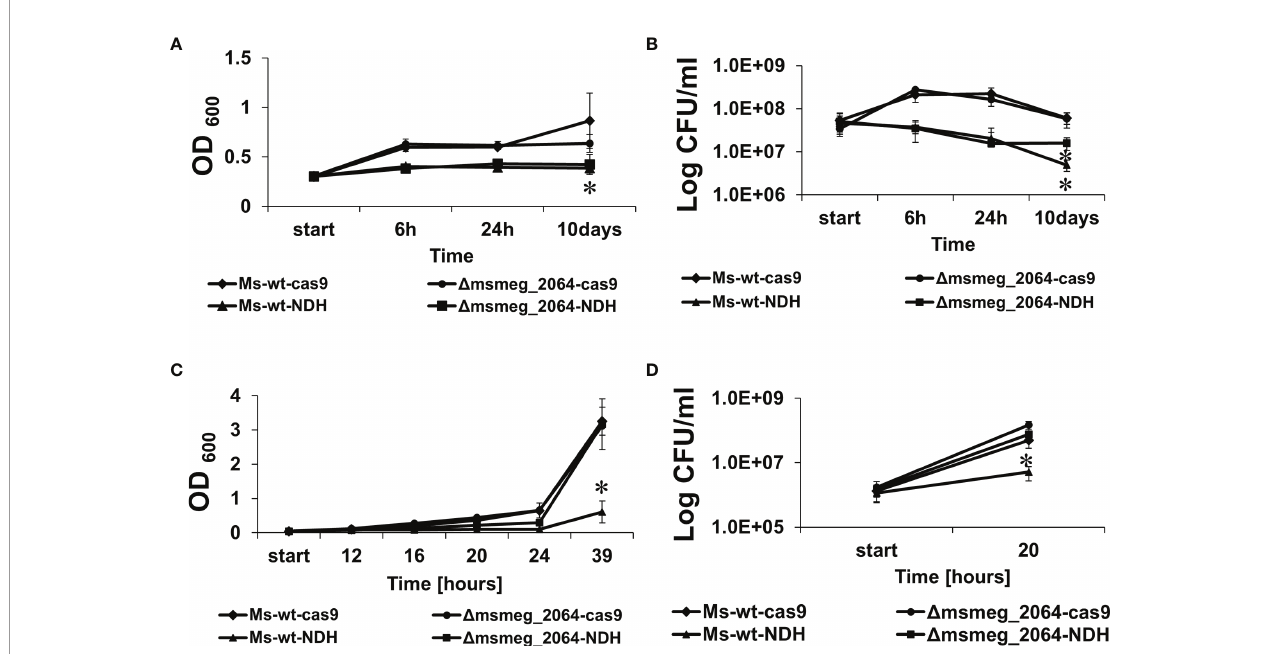
FIGURE 6 | Kinetics of growth and viability of Mycobacterium smegmatis strains expressing decreased levels of ndh gene. The mutant strains ndh CRISPRi/dCas9 (Ms-wt-NDH) and D msmeg_2064-ndh CRISPRi/dCas9 ( D msmeg_2064 -NDH) and control strains CRISPRi/dCas9 (Ms-wt-cas9) and D msmeg_2064 CRISPRi/dCas9 ( D msmeg_2064 -cas9) were grown in 7H9/AD Middlebrook medium for 16 h at 37°C with the addition of anhydrotetracycline to deplete ndh . Then, bacteria were cultured in limited oxygen access for 10 days (A, B) and subjected to reaeration for 39 h (C,D). The growth of strains was evaluated by measuring the OD 600 at the indicated time points (A,C), and the numbers of viable cells were determined as bacterial colony-forming units (CFU) per ml on 7H10/OADC plates (B, D). Mean ± SD from three independent experiments are shown. Statistical signi fi cance was determined using Student ’ s t-test (A) (* p < 0.01); (B) (* p < 0.0001); (C) (* p < 0.001); (D) (* p <